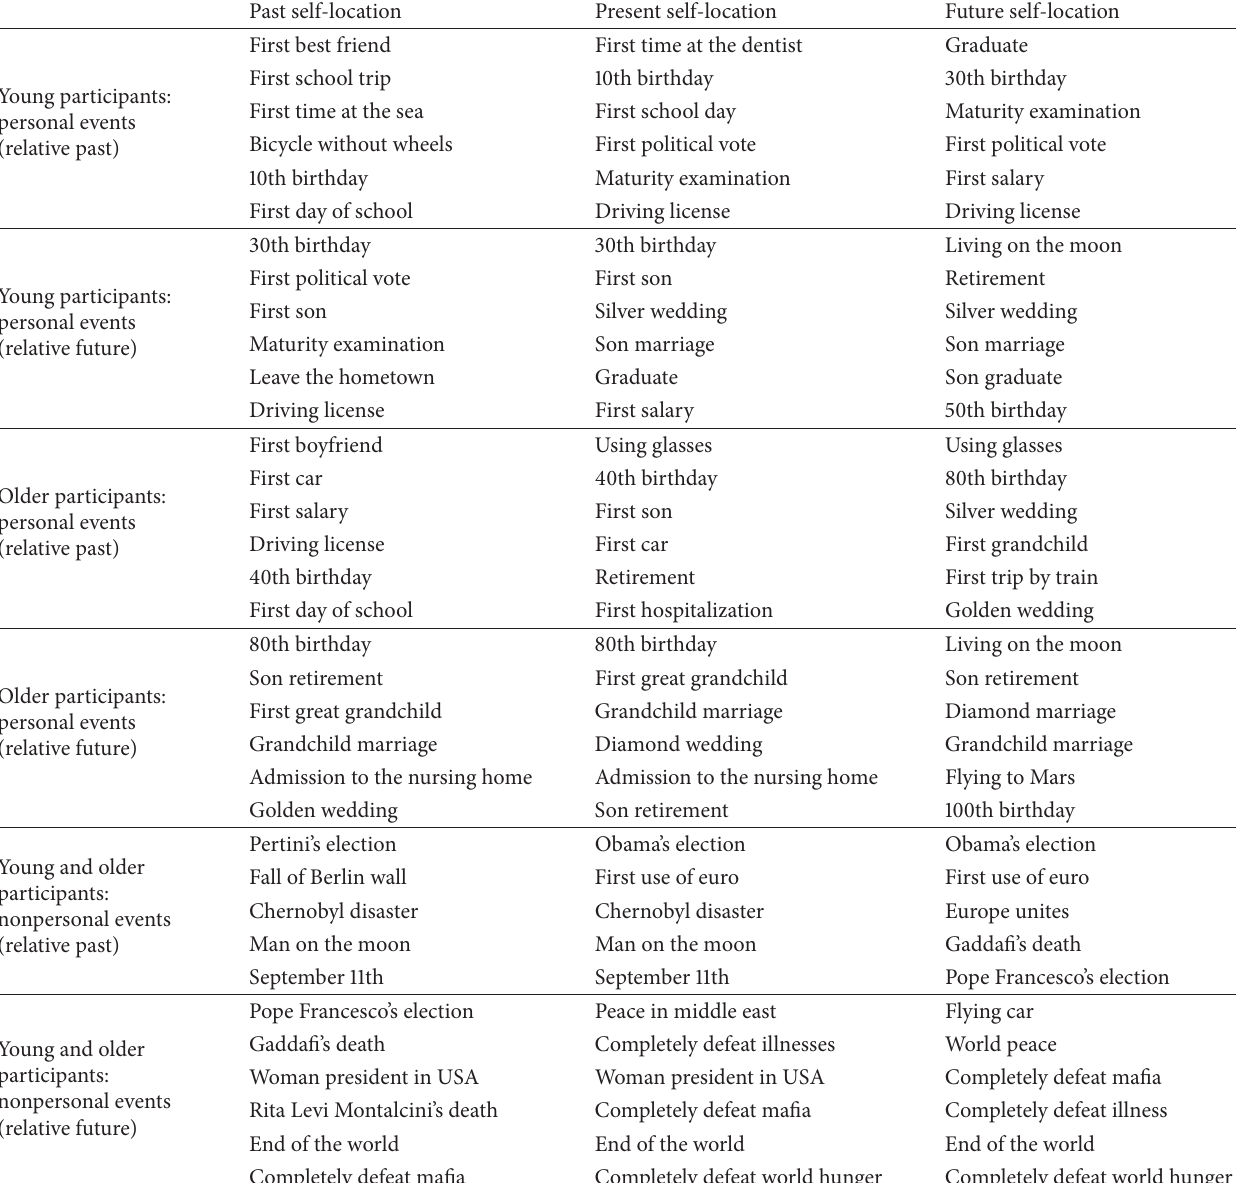
Table 1: List of events presented to young and older